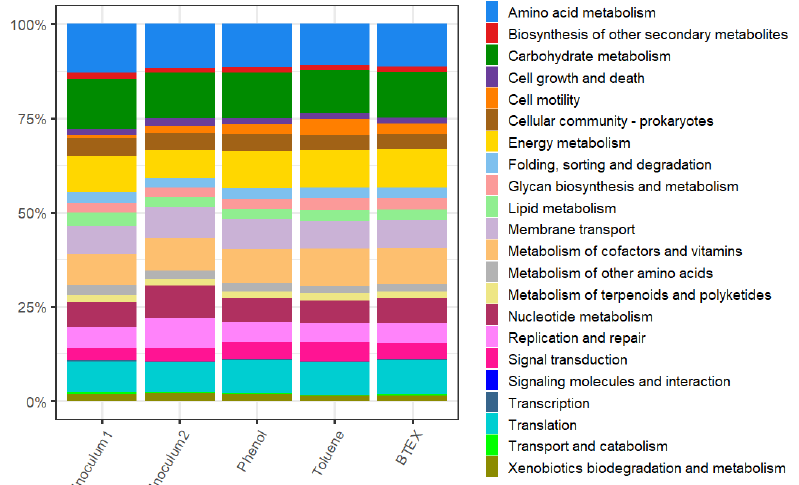
Figure 3. Distribution of genomic functions in inocula and anode metagenomes. The relative abundance for each sample was defined as the sum of the total number of coding DNA sequence assigned to Kyoto Encyclopedia of Genes and Genomes (KEGG) pathways (level 2), normalized over the total number of assignments to KEGG pathways for that